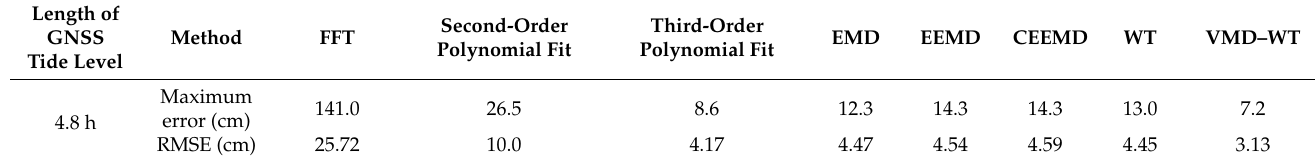
Table 3. Comparison of filtering effects of the eight methods for 4.8 h.